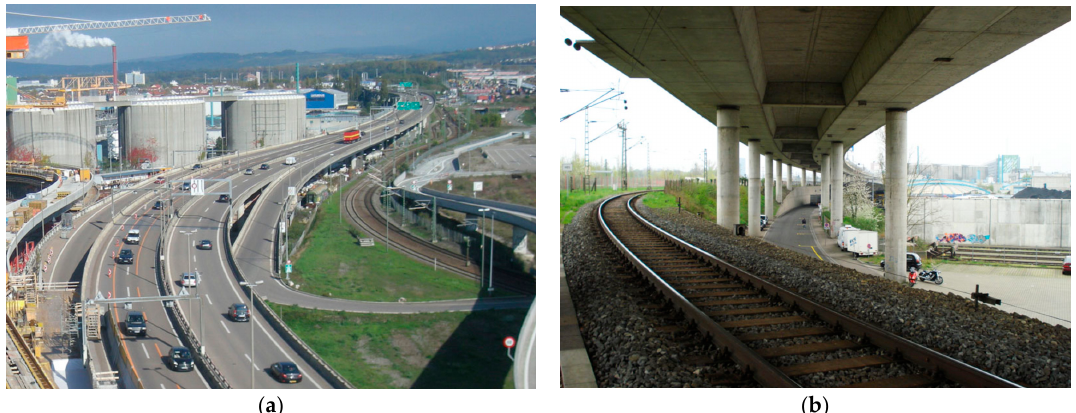
Figure 1. Basel border bridge: ( a ) view from above; ( b ) view from below.